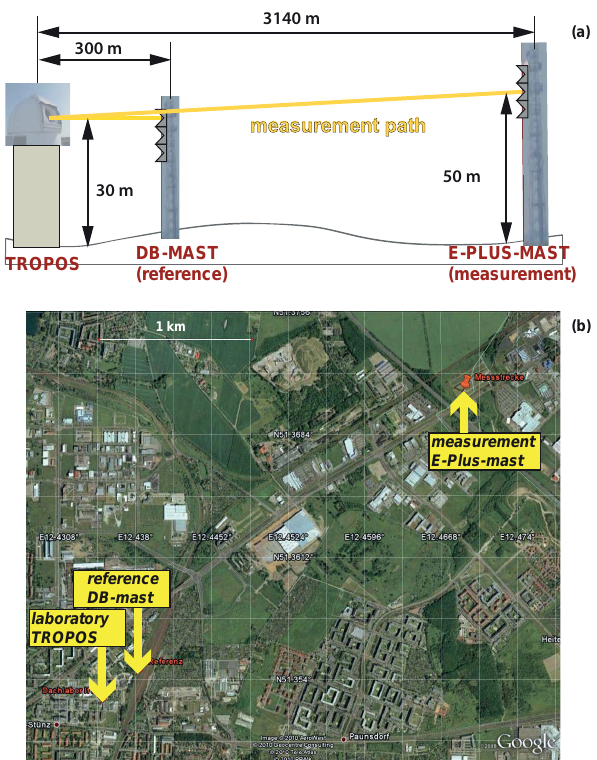
Fig. 2. (a) Sketch of the SÆMS reference and measurement pathes Fig. 2. a) Sketch of the SÆMS reference and measurement pathes outside of the TROPOS laboratory, and (b) Google Earth image outside of the TROPOS laboratory, and b) Google image with ref- with reference path (reference DB tower) and measurement path erence path (reference DB tower) and measurement path (measure- (measurement E-Plus tower). The distance between the reference ment E-Plus tower). The distance between the reference and mea- and measurement towers is 2.84km. The SÆMS field site is about surement towers is 2.84 km. The SÆMS field site is about 3 km 3km northeast of the Leipzig city center. The E-Plus tower is lo- northeast of the Leipzig city center (500000 citizens). The E-plus cated 250m east of a highway (Autobahn A14 from Magdeburg to tower is located 250 m east of a highway (Autobahn A14 from Magdeburg to Dresden).